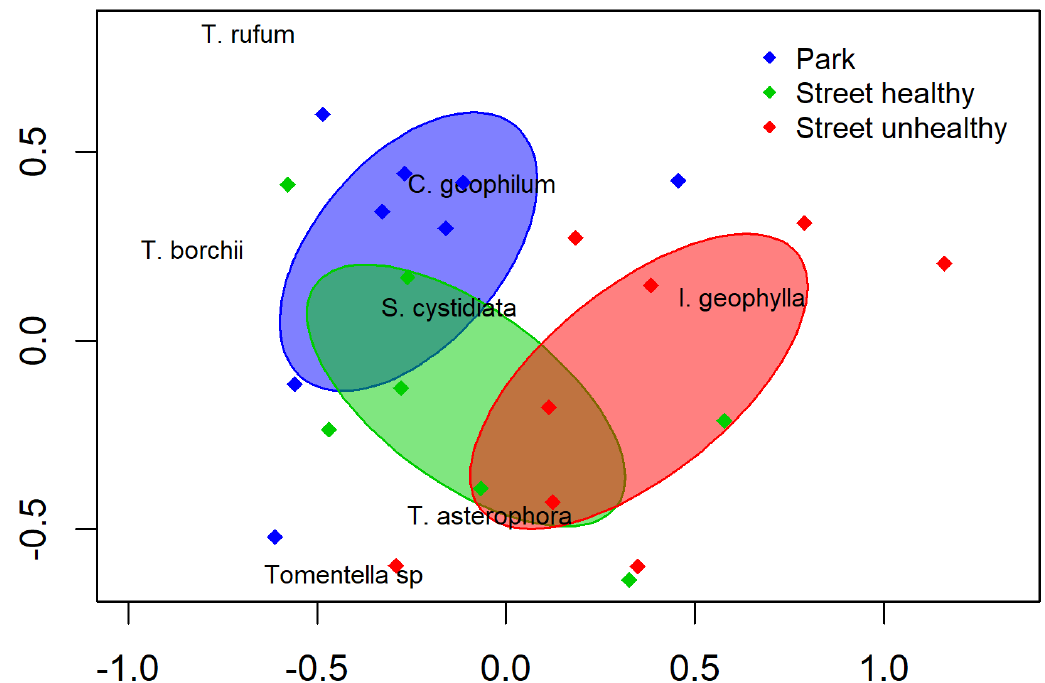
Figure 2. Non-metric MDS of the street and park trees based on the ectomycorrhizal community. Circles represent individual samples, whilst red crosses represent ectomycorrhizal fungal species. Ellipses indicate the standard deviation around the centroid position of each study treatment.